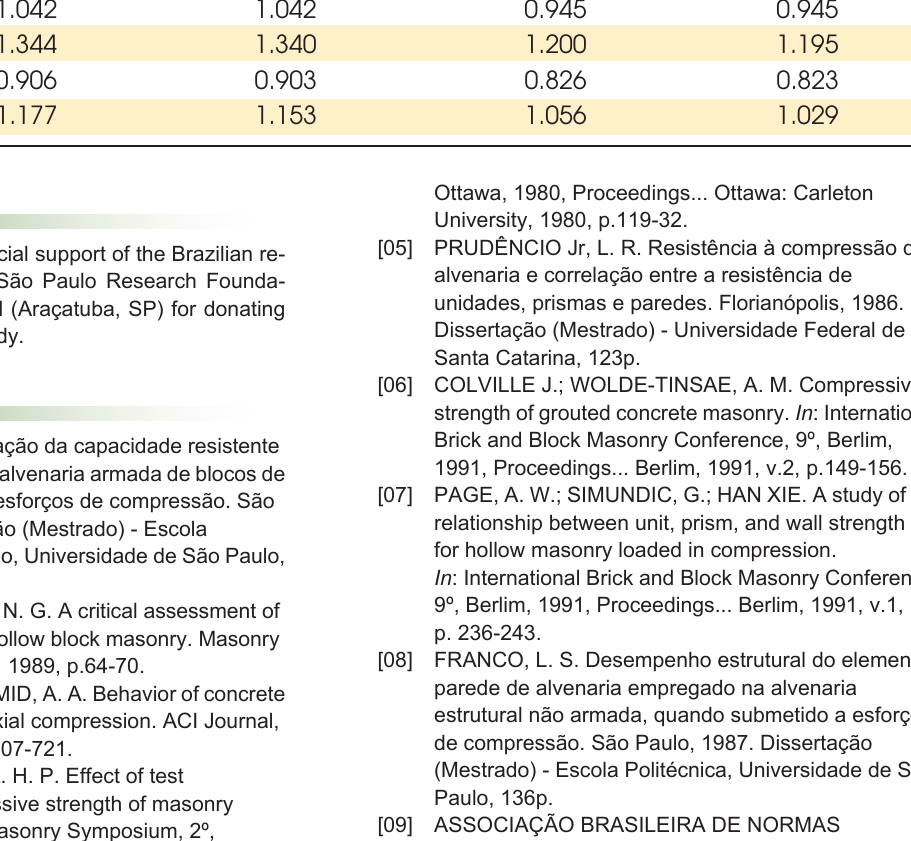
Table 13 – Relationship between experimental vs. theoretical break strains for all the models Test